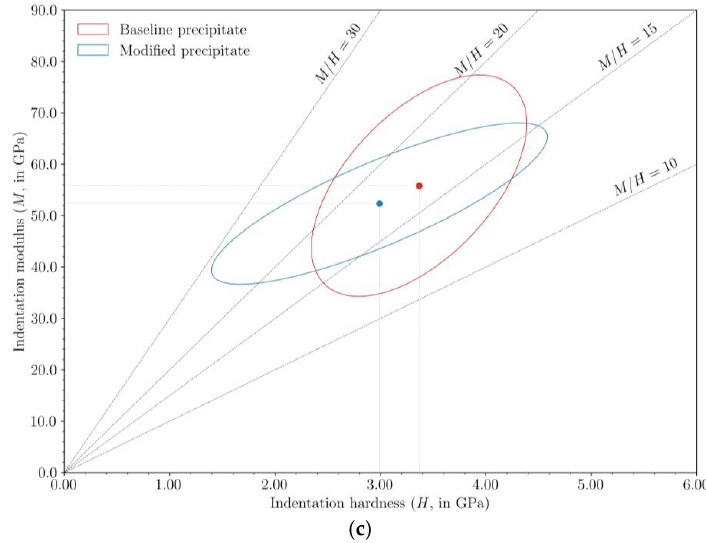
Figure 5. Measured indentation hardness and modulus of: ( a ) baseline precipitate; and ( b ) modified precipitate. Legend shows the particle number. Scatter plots of indentation modulus vs. indentation hardness for each particle are presented in Section C of Supplementary Information. ( c ) Comparison of 95% prediction ellipses derived from the M, H data cluster of the baseline and modified precipi- tates.